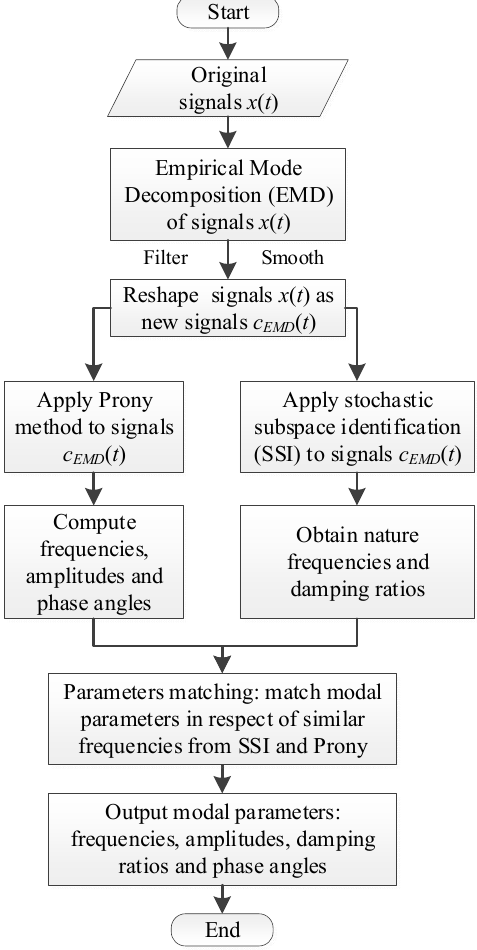
Figure 1. Flowchart of modal identification using the SMPI